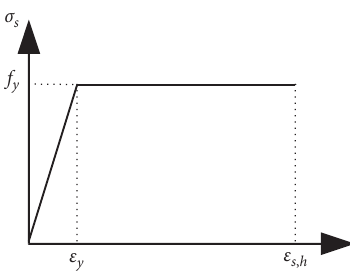
Figure 4: Schematic diagram of the bilinear law adopted to model the